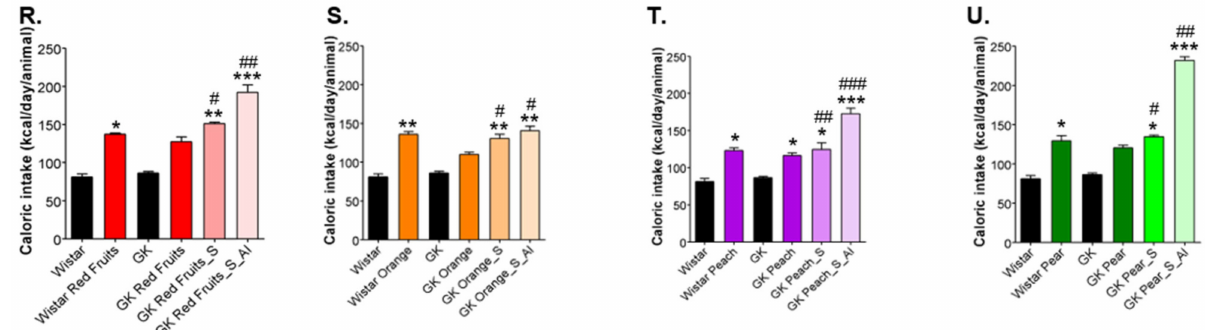
Figure 2. Normal and diabetic rats were treated for 4 weeks with fruit juices ad libitum. Diabetic rats were also treated during the same period with a matched sugary solution in the same volume (GK_S) or ad libitum (GK_S_AL) ( A ). Body weight was monitored during the experimental period ( B – E ) and weight gain calculated at each time-point ( F – I ). Food intake ( J – M ) and consumption of water/juice/sugary solution ( N – Q ) were monitored throughout all the experimental period. The total caloric intake/day was calculated ( R – U ). * different from Wistar; # different from GK; $ different from GK_Juice. & Different from GK_Juice_S. 1 symbol, p < 0.05; 2 symbols, p < 0.01; 3 symbols, p <